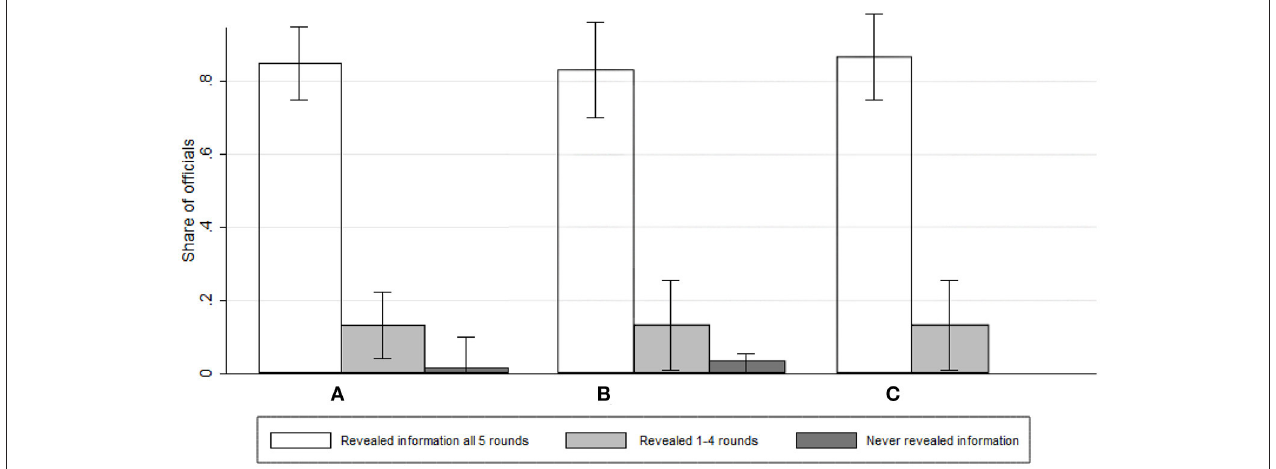
FIGURE 2 | Information avoidance by officials. (A) Pooled. (B) High externality. (C) Low externality.